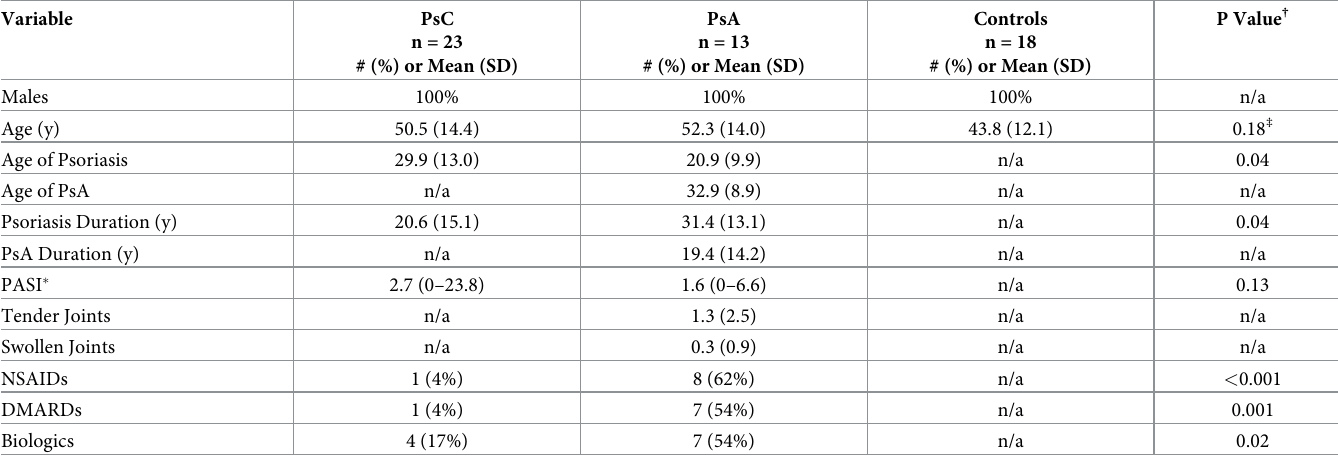
Table 1. Demographic and clinical characteristics of the study